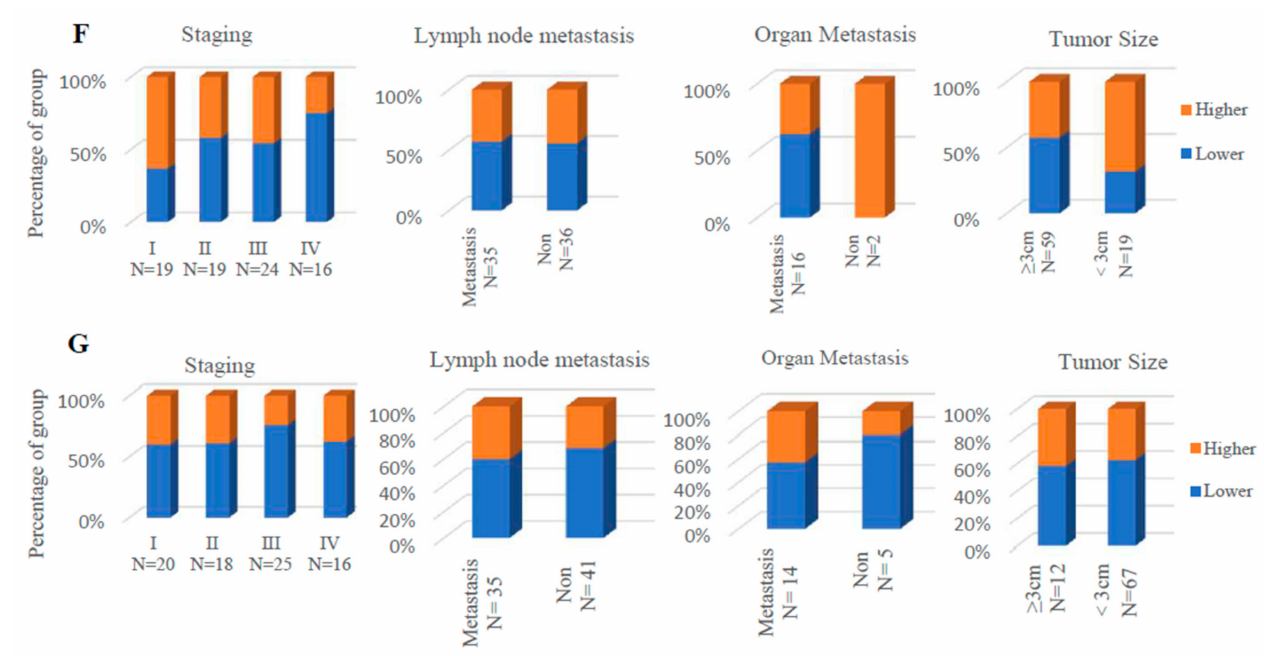
Figure 9. Higher expression of LPAR6 was correlated with clinicopathological parameters in LUAD cohort and was associated with increased overall survival (OS) of LUAD and LUSC patients. ( A ) Immunohistochemistry staining of the LPAR6 in the tumor and adjacent normal tissues. Red arrows indicated the cytoplasm-stained LPAR6. Bar, 50 µ m; ( B ) The immunoreactive score (IRS) of the cytoplasm LPAR6 staining in 74 paired lung cancer tissues in LUAD cohort; ( C ) The Kaplan–Meier plot of the OS for lung cancer patients with relatively higher or lower LPAR6 expression levels in LUAD cohort (N = 74; Log-rank test, p = 0.02); ( D ) The IRS of the cytoplasm LPAR6 staining in 78 paired lung cancer tissues in LUSC cohort; ( E ) The Kaplan–Meier plot of the overall survival for lung cancer patients with relatively higher or lower LPAR6 expression levels in LUSC cohort (N = 78; log-rank test, p = 0.04). ( F , G ) The proportion of LPAR6 expression level (higher or lower) in different clinical stages, lymph node metastasis, organ metastasis and tumor size of patients in LUAD ( F ) and LUSC ( G )